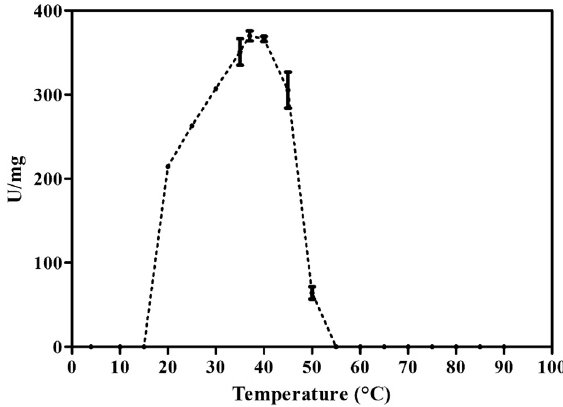
Figure 8. Relative activity at different temperatures. Values are represented as the mean ± standard deviation.